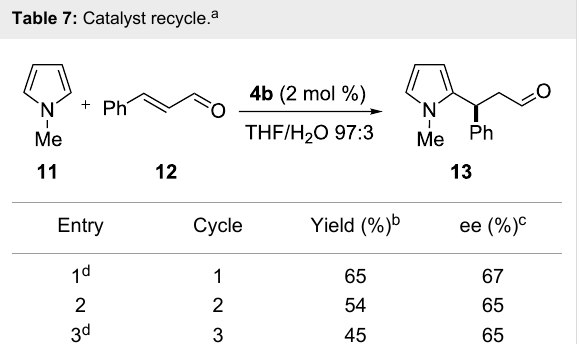
Table 7: Catalyst recycle.